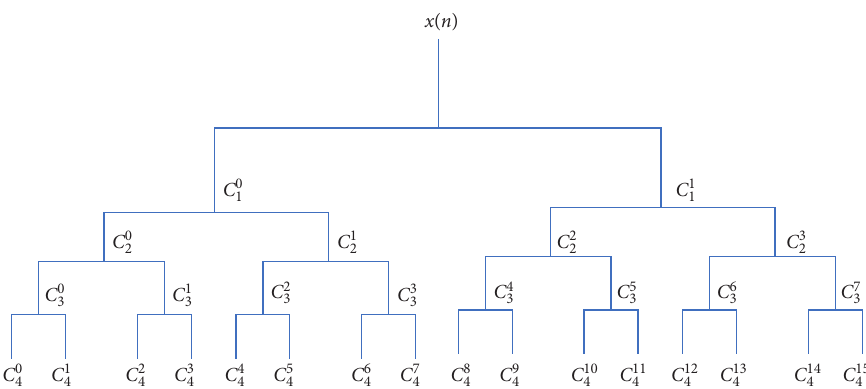
Figure 1: Fast computation of the kurtogram using an arborescent filter-bank structure.